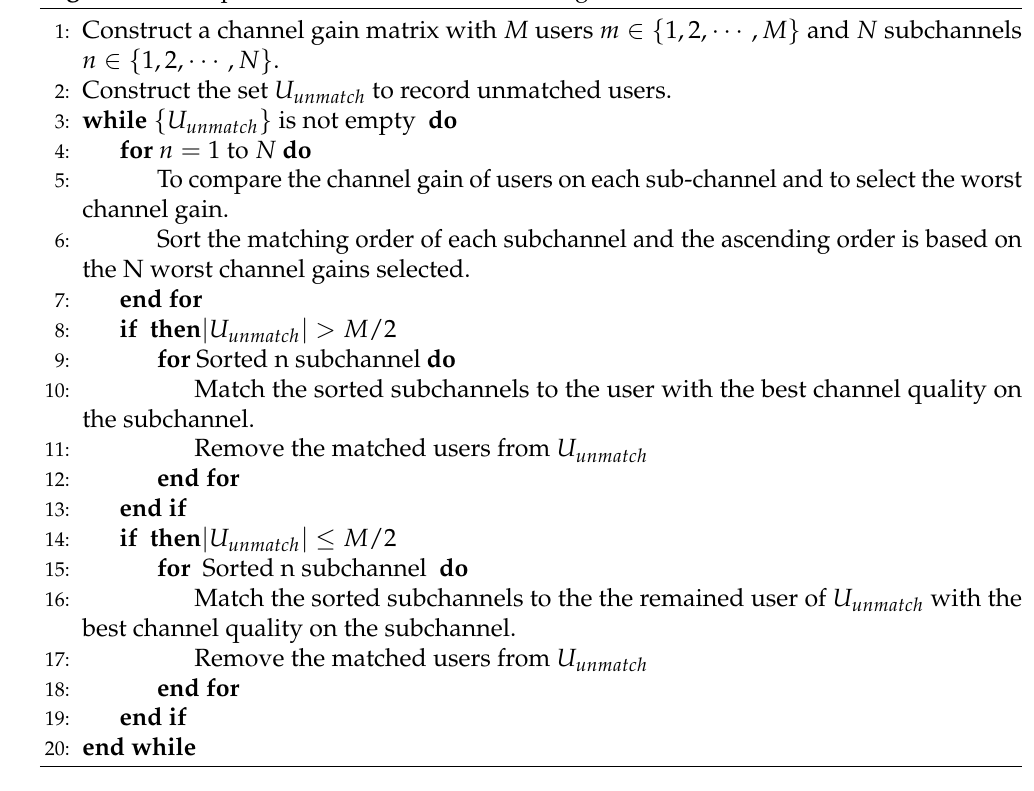
Algorithm 1 Proposed Subchannel Allocation